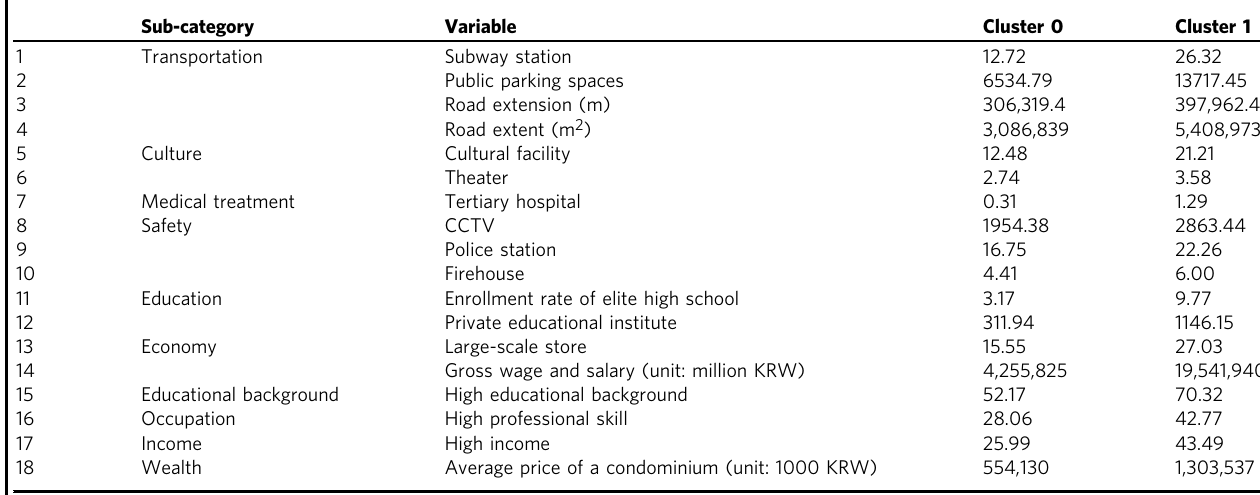
Table 3 Mean value of variable by cluster (Seoul).